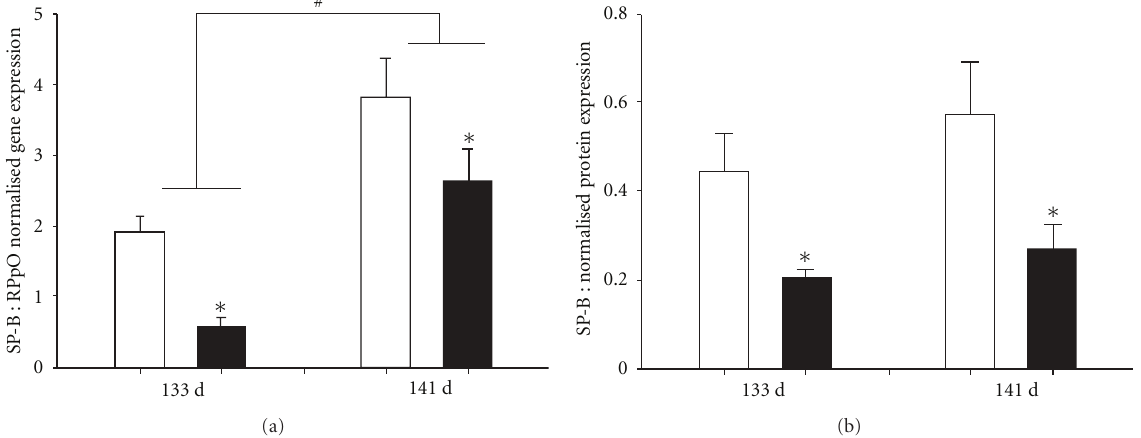
Figure 5: There is a decrease in gene (a) and protein (b) expression of SP-B (as well as for SP-A and -C, data not shown) in the lung of the chronically hypoxemic, PR sheep fetus (black bars) relative to the normally grown sheep fetus (open bars). ∗ P < 0 . 05 control versus PR; # P < 0 . 05 gestational age. PR: placental restriction. The figure is reproduced with permission from